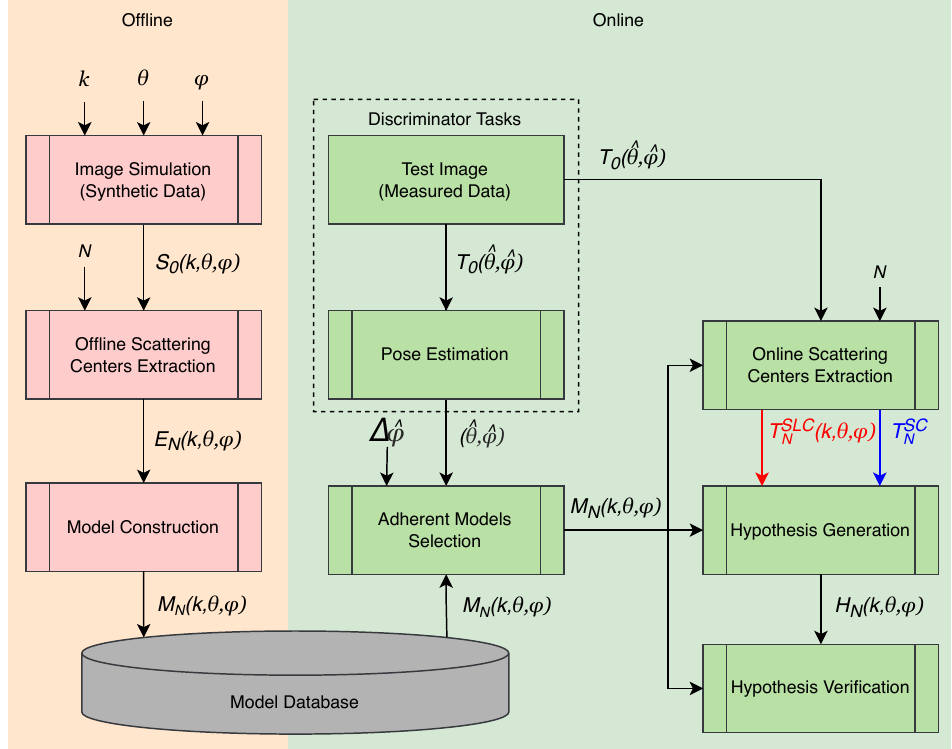
Figure 6. General design of the proposed classification